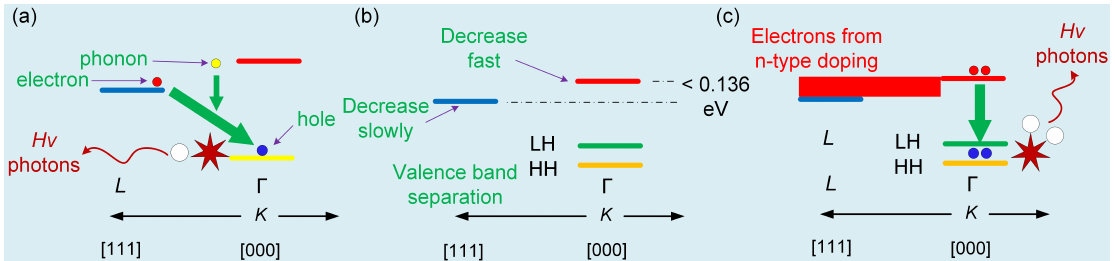
Figure 1. ( a ) Schematic band structure of an unstrained Ge well. ( b ) The schematic band structure of a tensile-strained Ge well. ( c ) The schematic band structure of a tensile strained Ge well via n-type